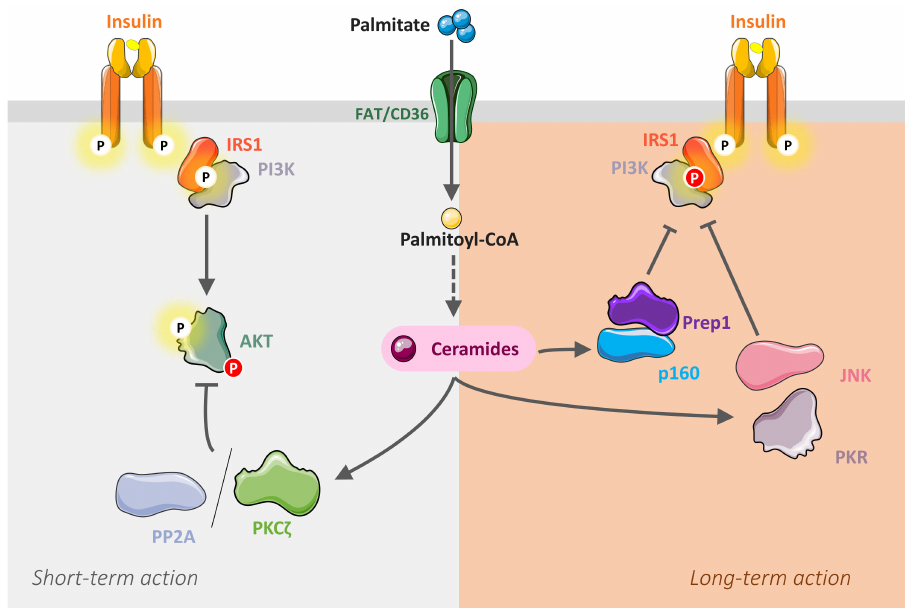
Figure 2. Short- and long-term action of ceramides on insulin signaling in muscle cells. Ceramides inhibit the insulin signaling pathway in muscle cells by targeting in a time-dependent manner two important actors, Akt and IRS1. Ceramides rapidly activate either PP2A or PKC ζ to inactivate Akt. In the long-term, ceramides induce PKR/JNK and/or Prep1–p160 axes to target IRS1. IRS1: Insulin receptor substrate 1; JNK: c-Jun NH2-terminal kinase; PI3K: Phosphoinositide-3-kinase; PKC ζ : Protein kinase C ζ ; PKR: Double stranded ARN-activated protein kinase; PP2A: Protein phosphatase 2A. Prep1: Pbx regulating protein 1. Dotted arrows: indirect action; Solid arrows: direct action. P: